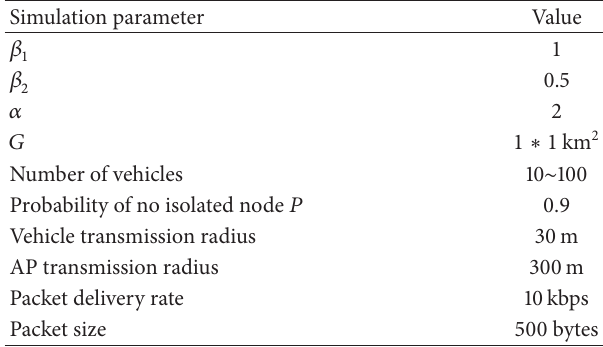
Table 1: Main simulation parameter